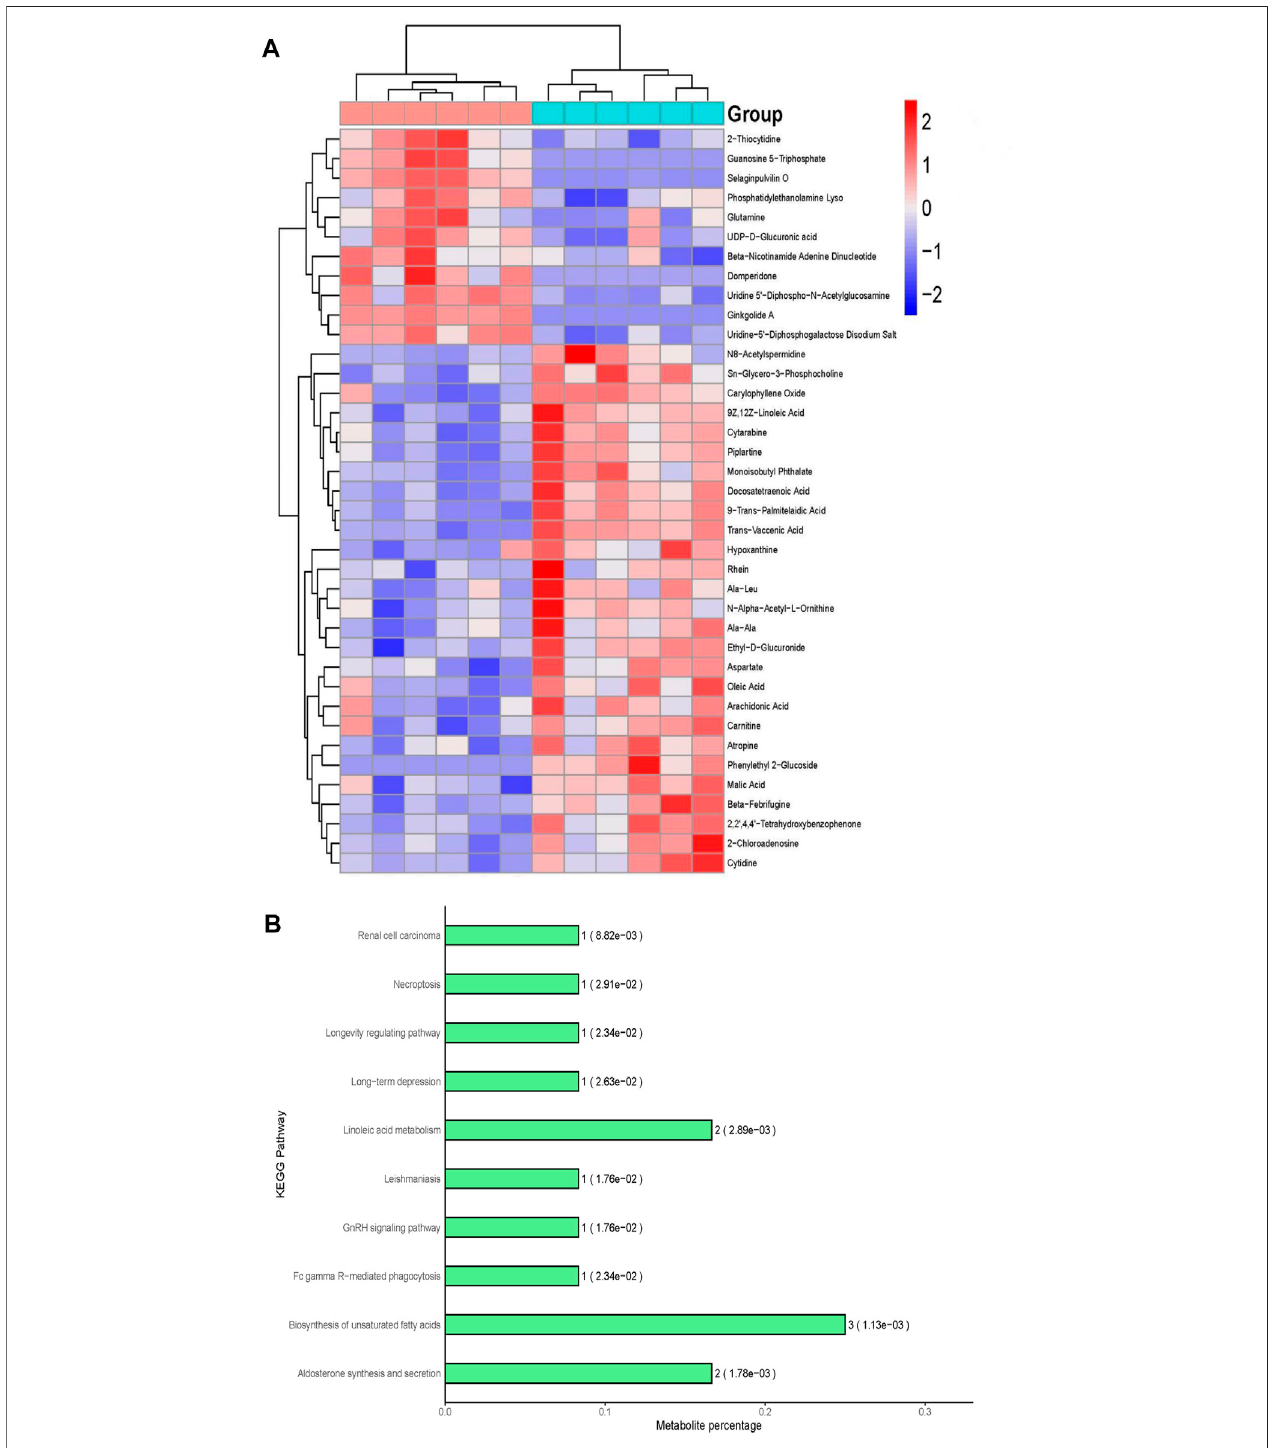
FIGURE 4 | Effects of DAPA on the metabolites of HRMECs. (A) Metabolites hierarchical clustering analysis. Blue means down-regulation, and red means up- regulation. The darker the color, the more obvious the difference. (B) Bar chart of signi fi cantly different metabolites KEGG metabolic pathway enrichment analysis (Top10). (C) Bubblechartofsigni fi cantlydifferentmetabolitesKEGGmetabolicpathwayenrichmentanalysis(Top10).Theabscissarepresentedtheenrichmentrate;the larger the graph, the greater number of differential metabolites; the color indicated the signi fi cance of enrichment, namely p -value, and the redder indicated the more signi fi cance, the color gradient on the right indicated the size of the p -value.